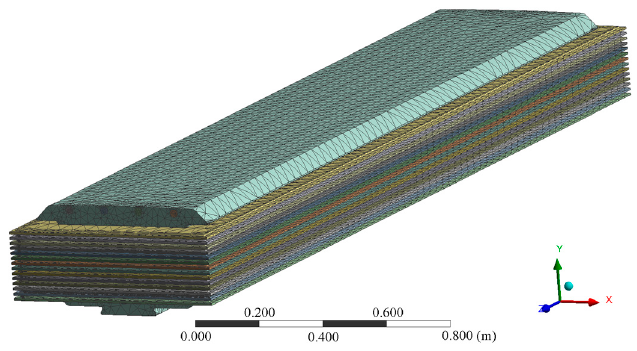
Figure 2. Subdivision of rotor magnetic pole solution domain.